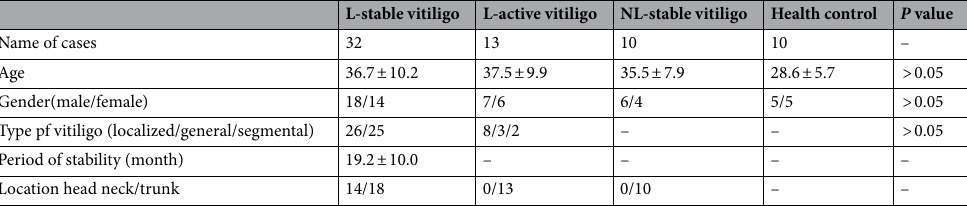
Table 1. Demographic and clinical data of stable vitiligo group (treatment group), active vitiligo group, and control group.